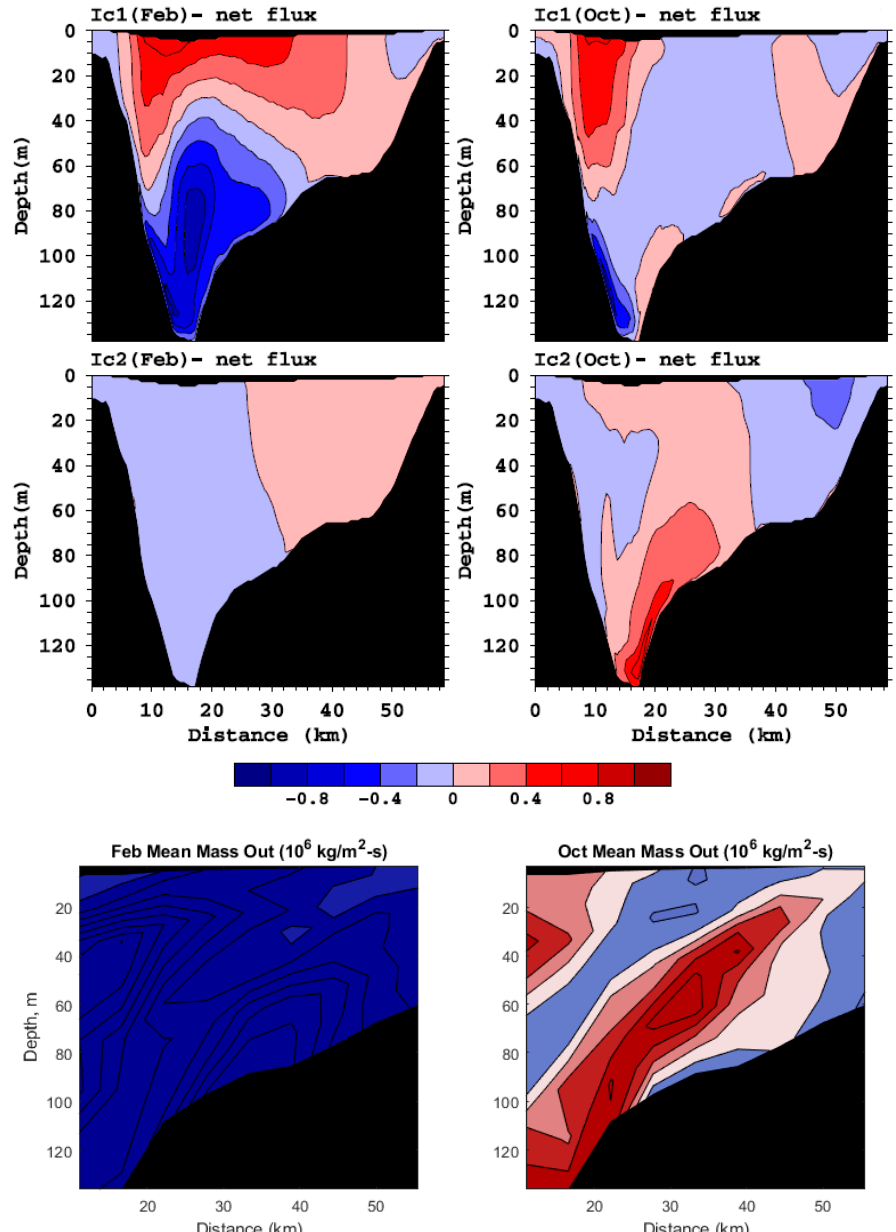
Figure 10. Average water fluxes (in 10 6 kg/m 2 -s) across the Strait of Hormuz for February and October. Positive fluxes (red) represent flow out of the Gulf. Top row indicates Ic1, the high-salinity equilibrium attained by a high initial conditions of salinity (Gulf-wide salinity = 40 g/kg), predicted by FVCOM model (from [19]). Middle row indicate Ic2, the low-salinity equilibrium attained by low initial conditions for salinity (Gulf-wide salinity = 25 g/kg) predicted by [19]. Bottom row indicates model predictions from the current Delft3D model.